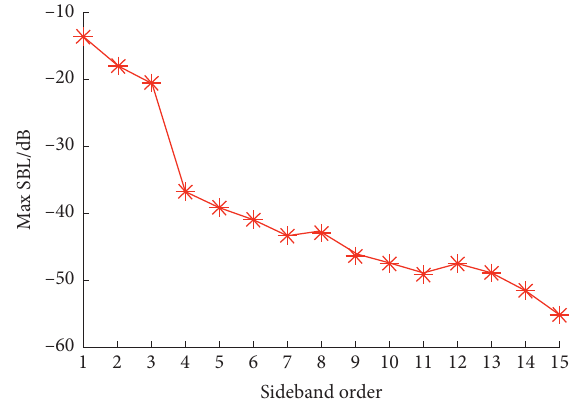
Figure 13: The SBL from the second sideband to the 20 th